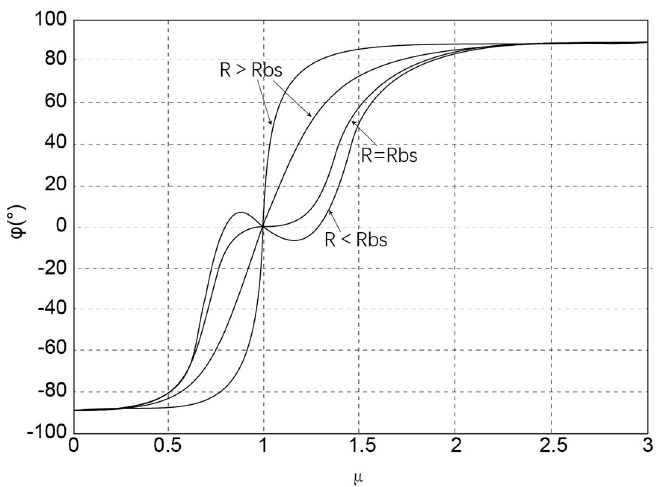
Figure 3. System impedance phase vs. equivalent load.